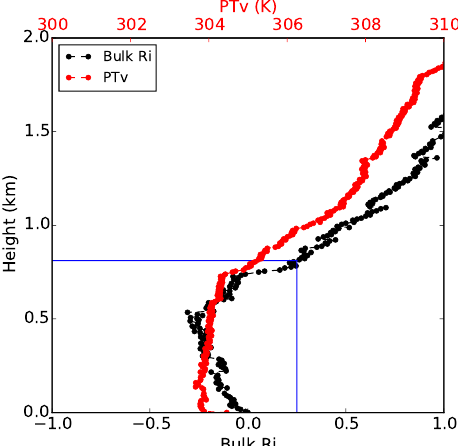
Figure 2. Vertical profiles of the bulk Richardson number ( Ri , in black) and virtual potential temperature (PTv, in red) based on L- band sounding observations made in Beijing on 30 June 2013 at 14:00BJT. The boundary layer height is the height where Ri first reaches the value of 0.25 (the blue